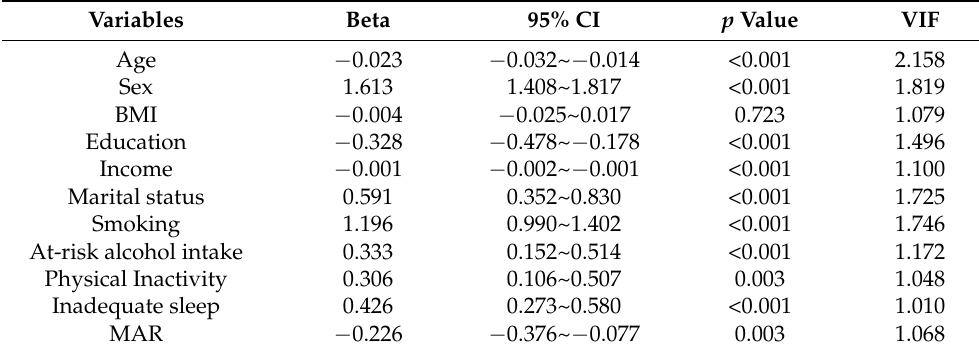
Table 2. Linear regression analysis for the determinants of depression in study participants.